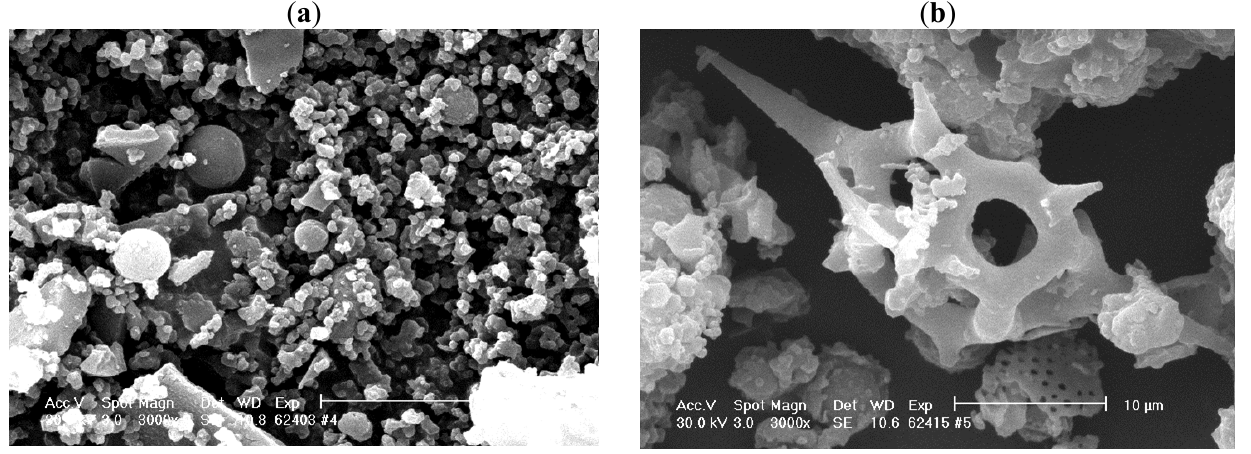
Figure 5. SEM micrographs of ( a ) sol-gel entrapped and ( b ) entrapped and adsorbed CaLB lipase. The sol-gel matrix was obtained with PhTMOS, MeTMOS and TMOS at 1.6:0.4:1 as additive. For the combined immobilization, molar ratio and the ionic liquid [Omim]BF 4 Celite 545 was employed as